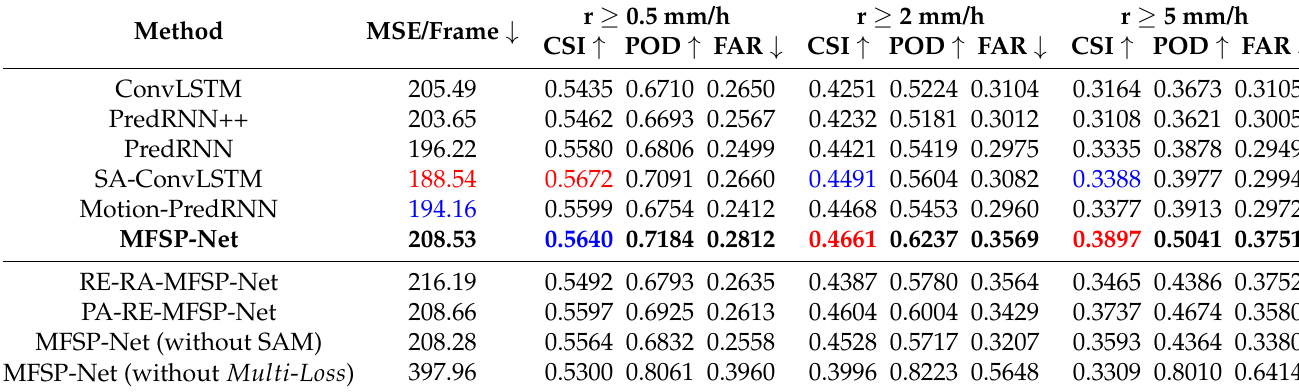
Table 8. Average evaluation results of 10 frames of precipitation intensity nowcasting in the first two hours.